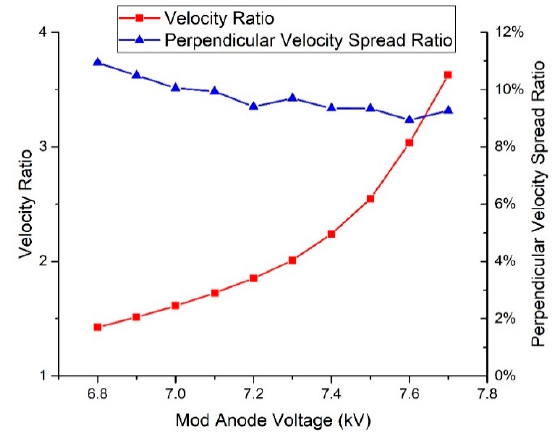
Figure 8. Variation of velocity ratio ( α ) and perpendicular velocity spread ratio with operating current.